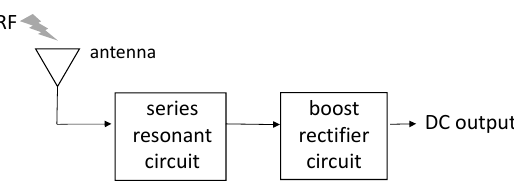
Figure 1. Block diagram of the energy harvesting circuit. RF: radio frequency. Sensors 2017 , 17 , 1763